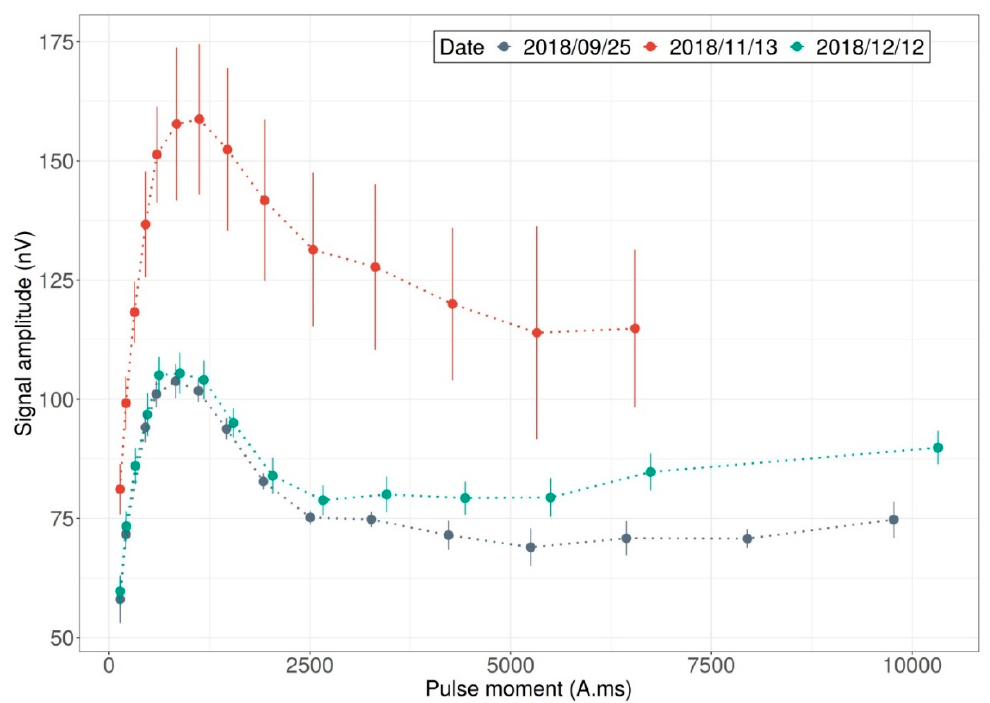
Figure 3. Temporal variability in the SNMR signal. Signal amplitude as a function of the energizing